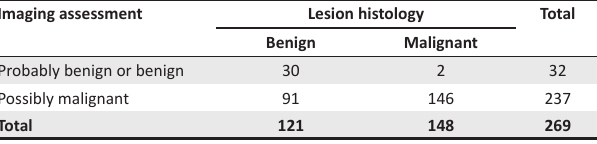
TABLE 5: Two-by-two table comparing the imaging assessment and histology results. Imaging